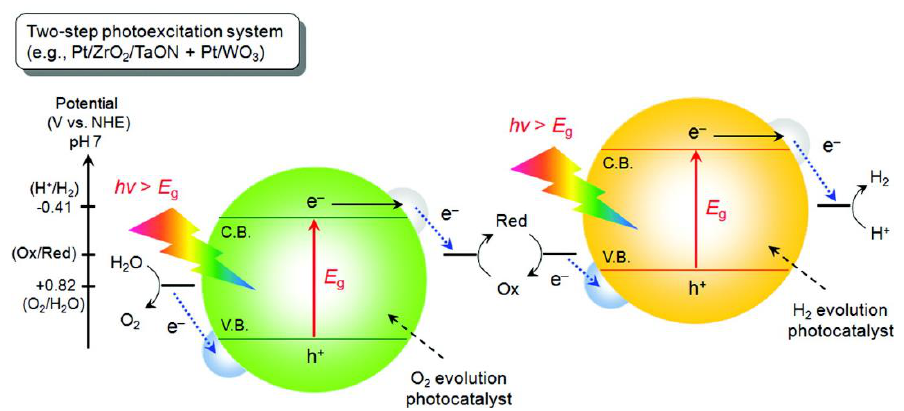
Figure 5. Figure 5. Schematic illustration of photocatalytic water-splitting by Z-system. C.B.—conduction